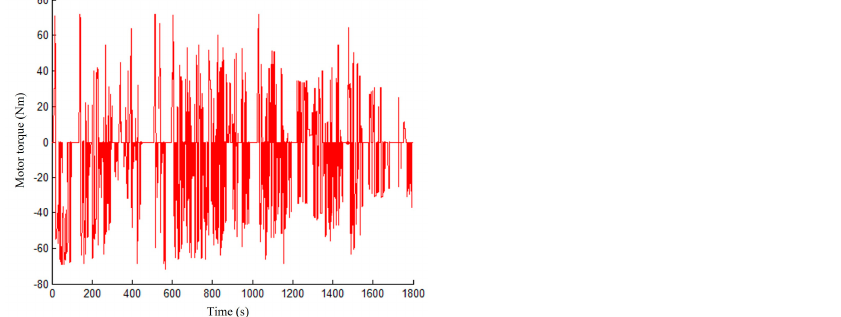
Figure 11. Engine load corresponding to different power systems under WLTP test conditions. Figure 12. Distribution of engine operating conditions under NEDC test conditions. Figure 13. Distribution of engine operating conditions under WLTP test conditions.